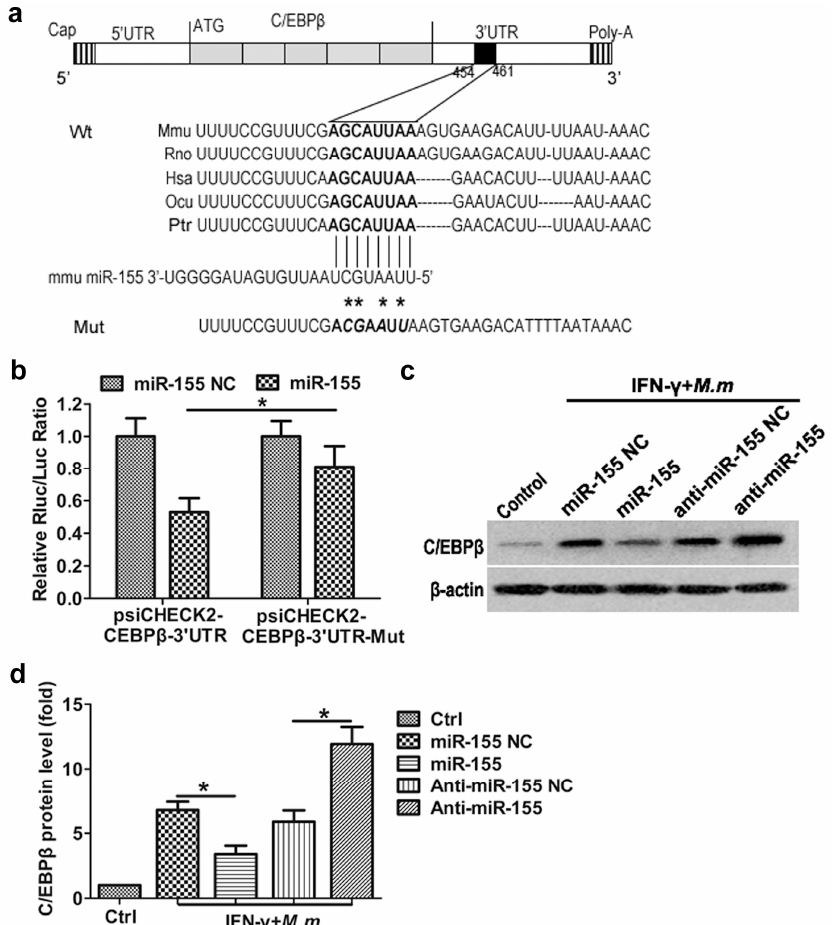
Figure 4. Translational inhibition of C/EBP β by miR-155. ( a ) Schematic drawing of the C/EBP β transcript. Sequence alignment and evolutionary conservation between miR-155 and its theoretical binding sites in the 3 ′ UTR of C/EBP β mRNA from several indicated species, with sequences recognized by miR-155 seed sequence shown in bold. The sequence of C/EBP β 3 ′ UTR mutant used for reporter assay is also shown (asterisk); ( b ) luciferase reporter constructs containing 3 ′ UTR (psiCHECK2-C/EBP β 3 ′ UTR) or mutant 3 ′ UTR (psiCHECK2-C/EBP β 3 ′ UTR-mut) of C/EBP β gene was cotransfected with miR-155 or miR-155 NC in HEK 293T cell and the luciferase activities (Renilla/firefly) were assayed; ( c ) Western blot analysis of C/EBP β in RAW 264.7 cells; ( d ) integrated band densities were obtained by scanning using a densitometer. Data are representative of three independent experiments. Results shown are the mean ± SEM. * p < 0.05.